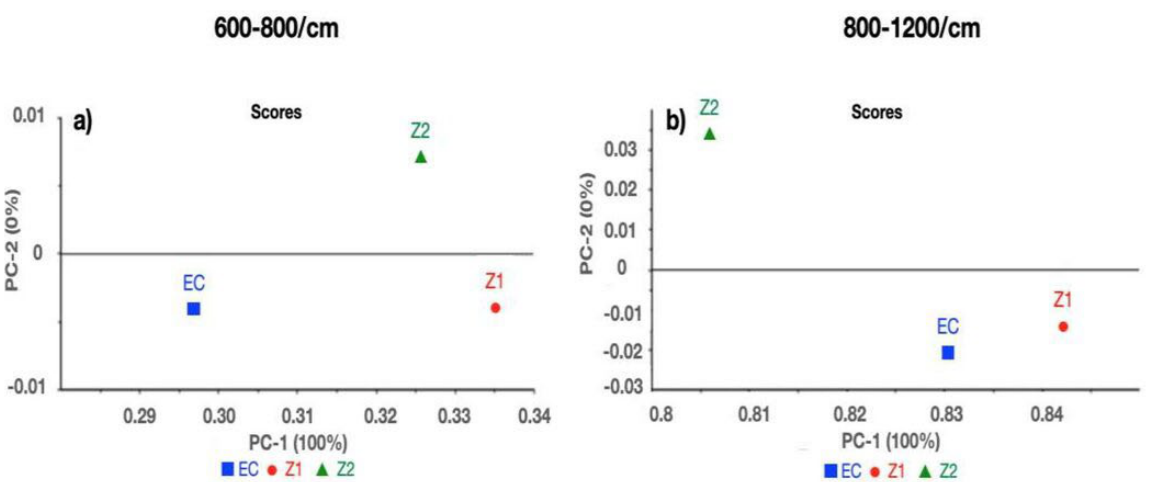
Figure 2. Principal component analysis (PCA) of EQUIA coat (E), 1% ZnO (EZ1), and 2% ZnO (EZ2) at spectral ranges ( a ) 600–800/cm, ( b ) 800–1200/cm, ( c ) 1200–1800/cm, and ( d ) 2700–3800/cm. Sample groupings and inner group variations were observed using cluster analysis (Figure 3a,b), which complemented the findings of the principal component analysis. Maximum differences were observed in E and EZ1 at the complete spectral range (Figure 3b). However, exceptional separation was overall recorded between the comparisons (a),(b). The FTIR spectra analyses of the peak height of the control and experimental sam- ples are shown in Figure 4. It was found that the intensities of peak groups (C–H, C=O, C=C, N–H, and C–O–C) were reduced after incorporating ZnO and TiO 2 in EC.